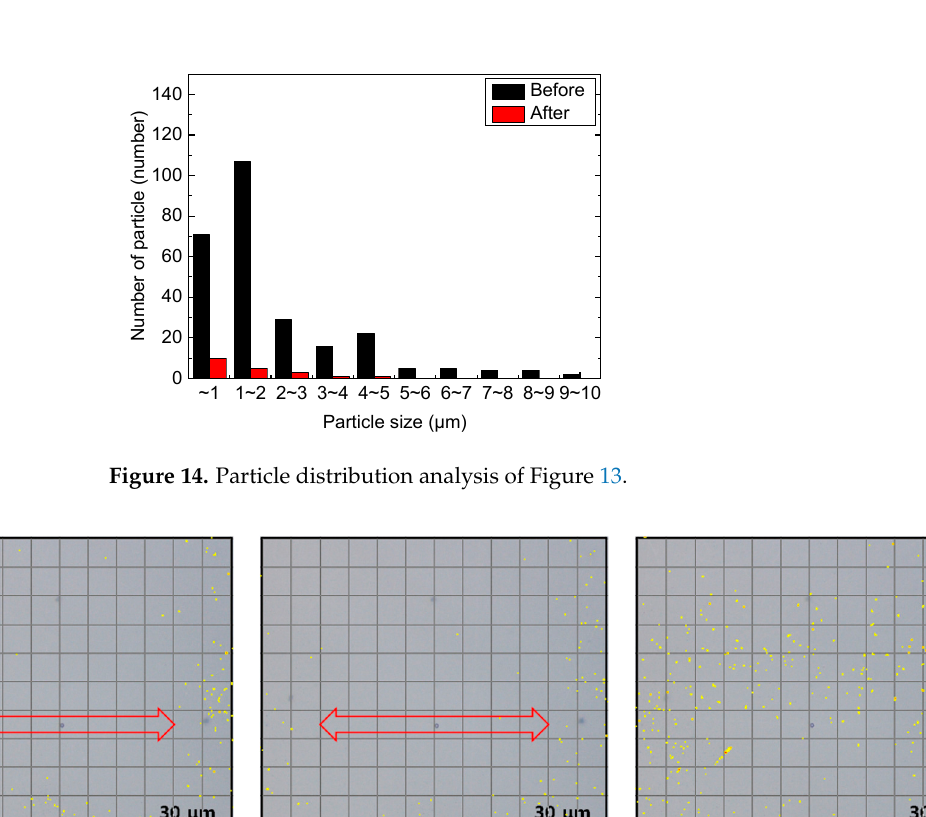
Figure 13. ( a ) Photo of before cleaning when pulse number is 110 number and gap distance is 20